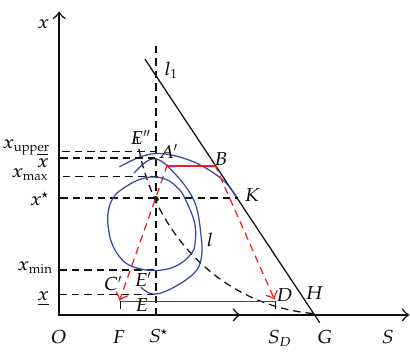
Figure 4: Illustration of system (cid:5) 2.6 (cid:6) for the case where x max < x set < x upper